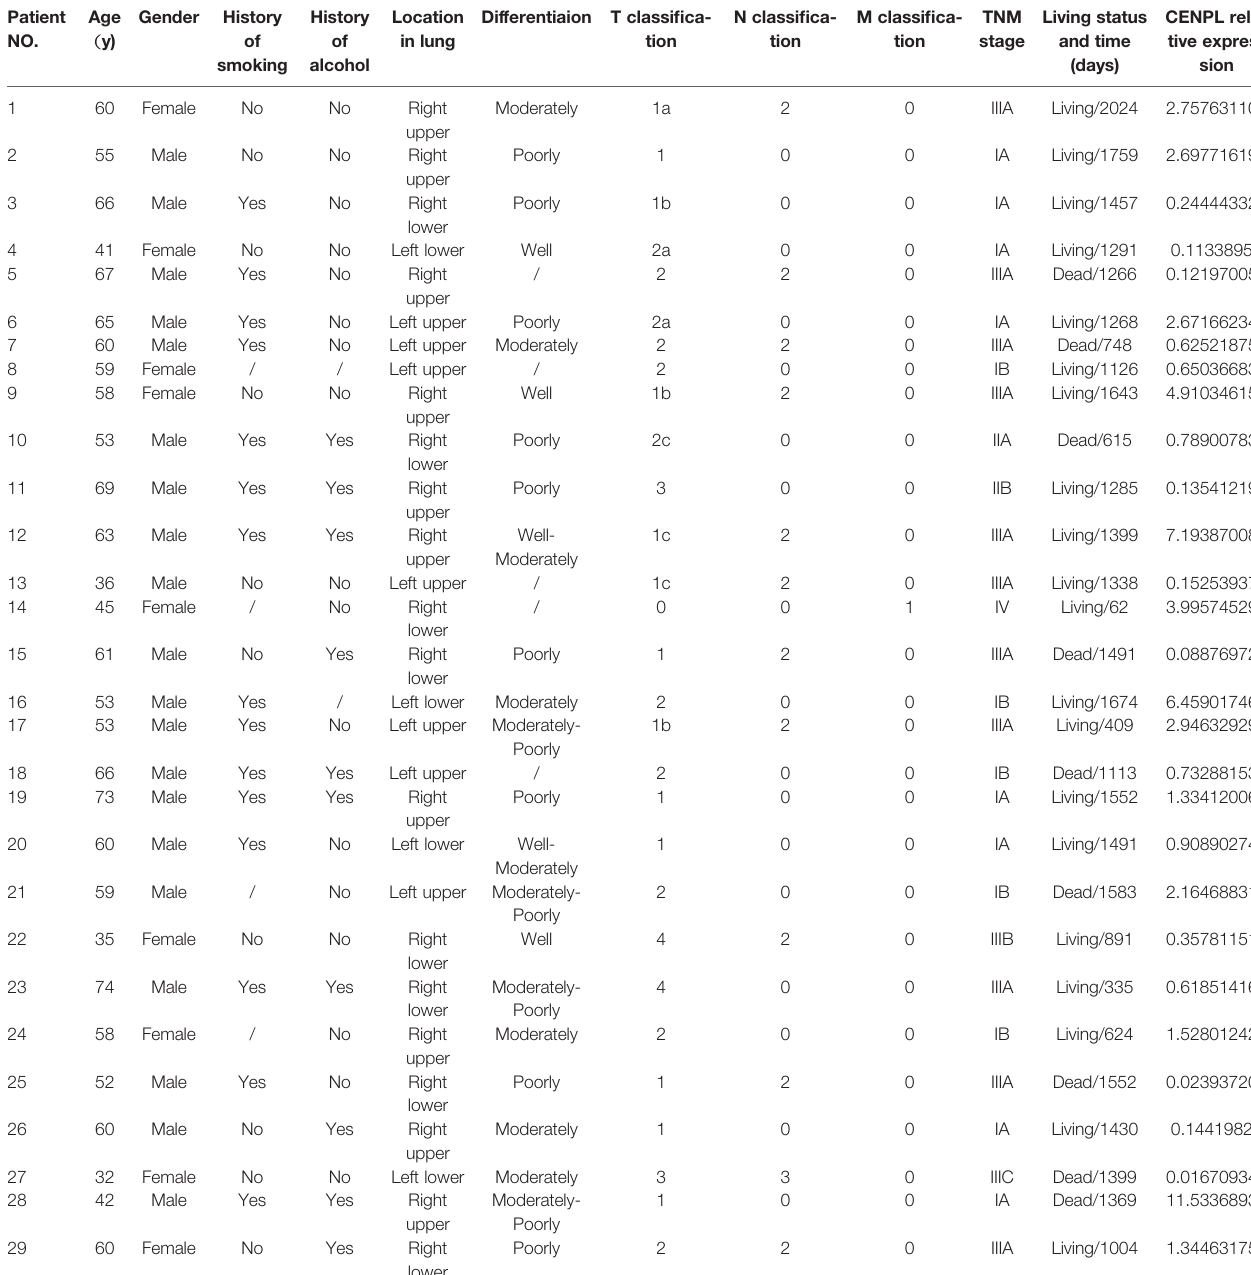
TABLE 1 | Clinicopathological parameters of LUAD cohort in Xiangya Hospital. Patient